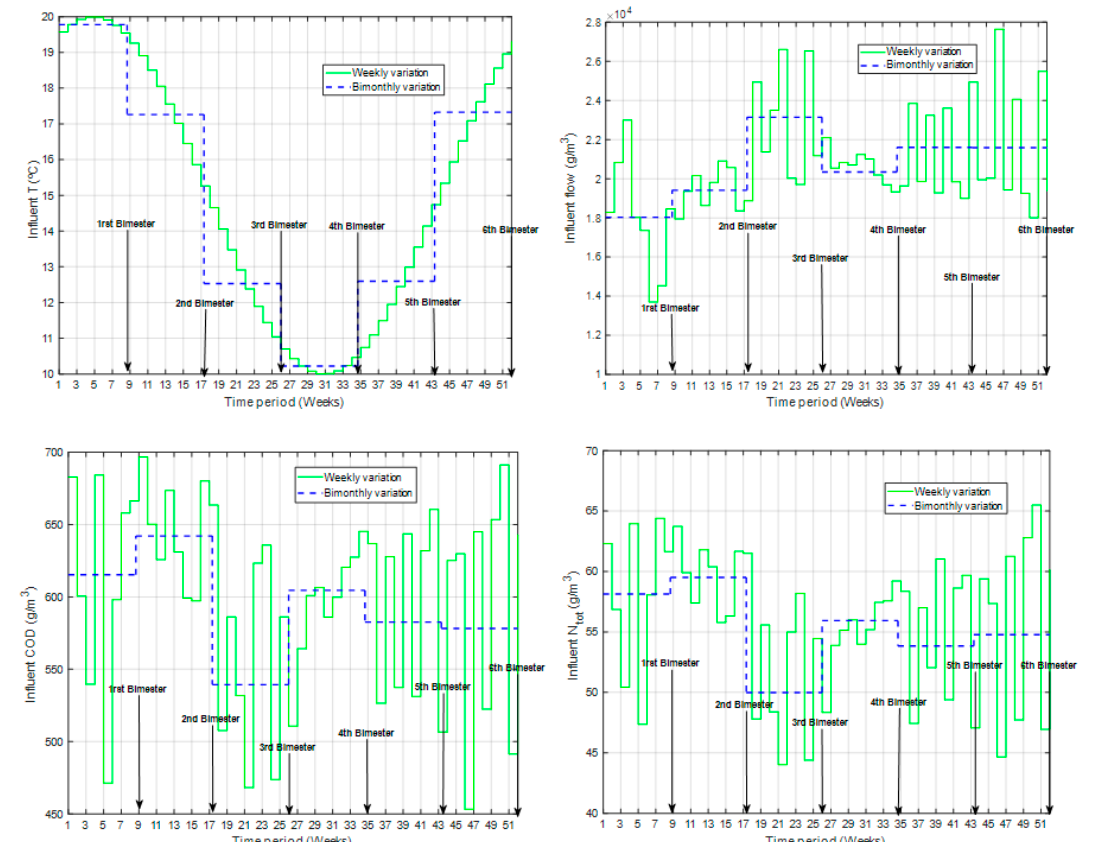
Table 2. Characteristic values of the significant variables of the influent including weekly and